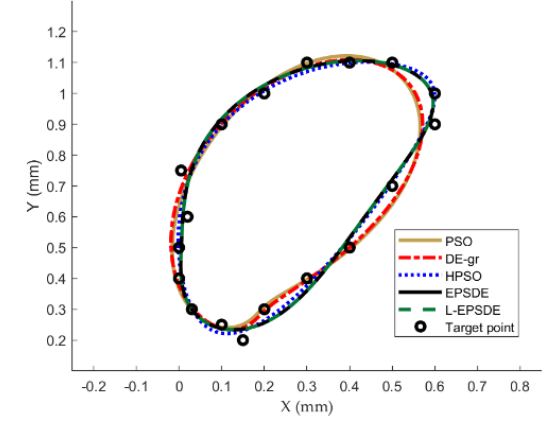
Figure 11. Trajectories of the coupler point of Case 2.